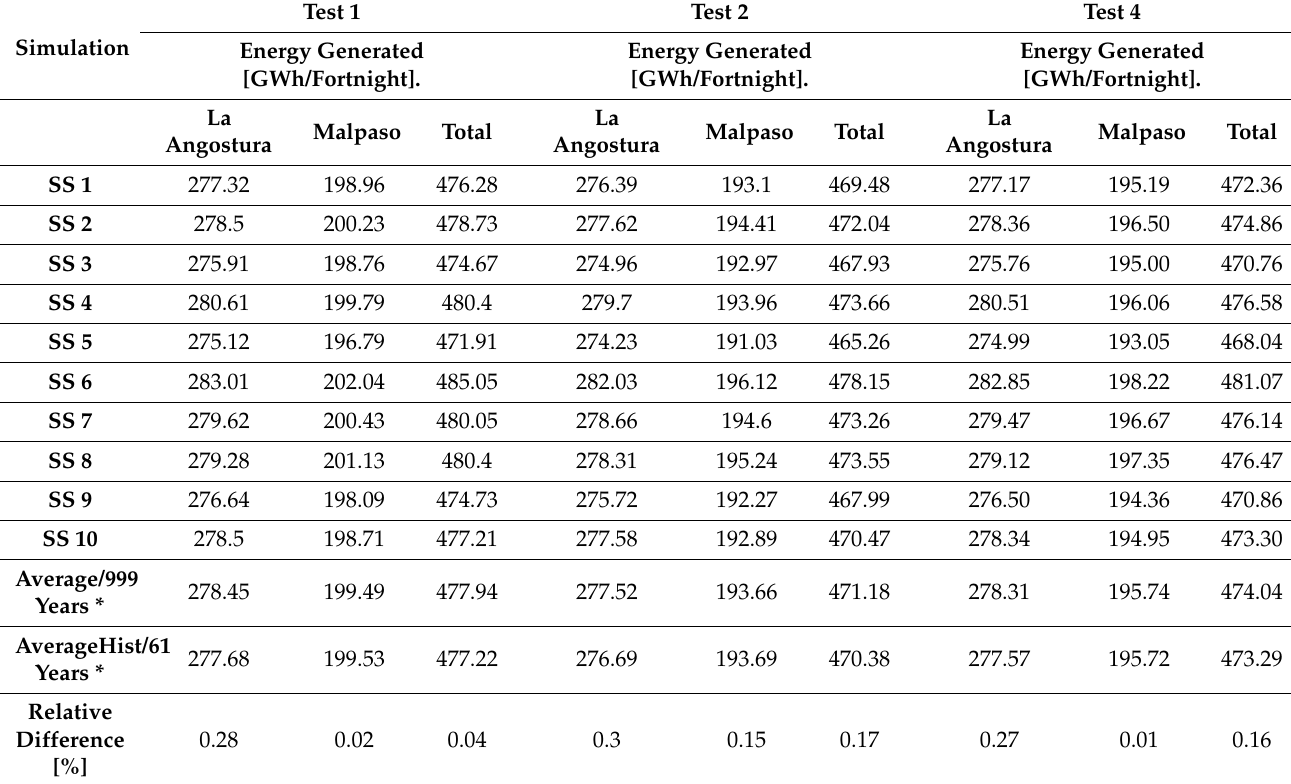
Figure 11. Guide curves tested for the policy with the combined guide curve, Test 4. Table 11. Comparison of total deficit: 10 synthetic series vs. historical records.